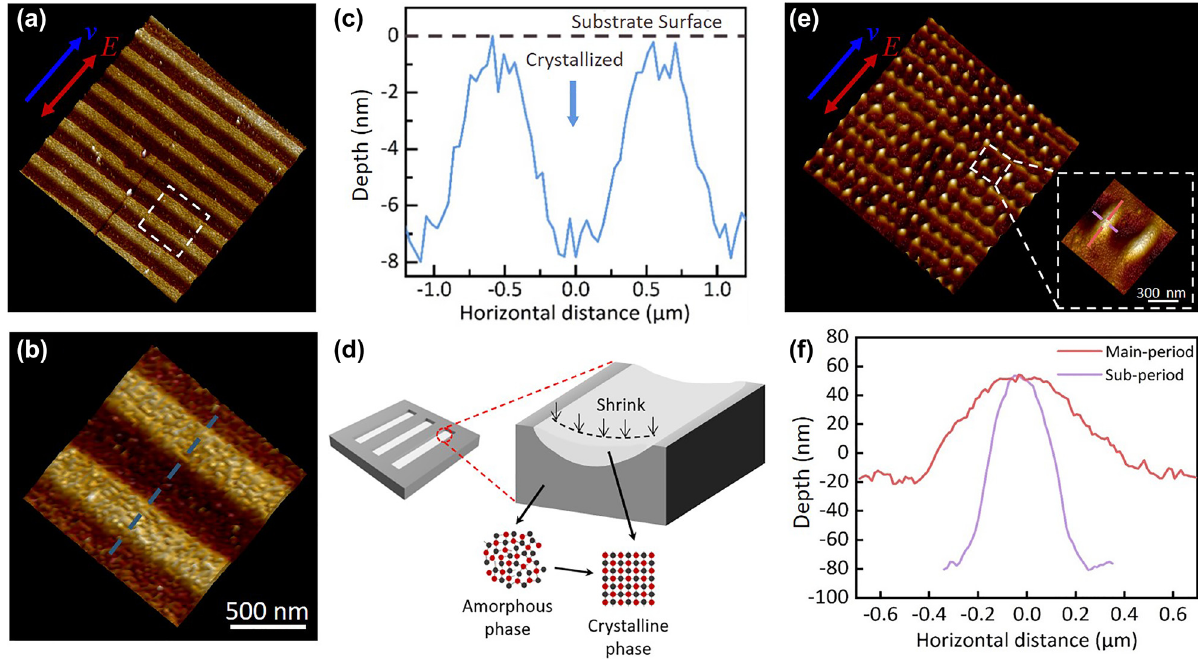
Figure 3: AFM images of the modified ripple structure and ablated nanodots. Figure (a)–(c), and (e)–(f) present the depth and period of the modified ripple structure and ablated nanodots structure, respectively. (d) presents a schematic of the formation of a modified ripple structure with the features of periodic diffractive gratings. The magnified view of the white frame marked in (e) is shown in the inset of (e). (b) is a magnified view of the white frame marked in